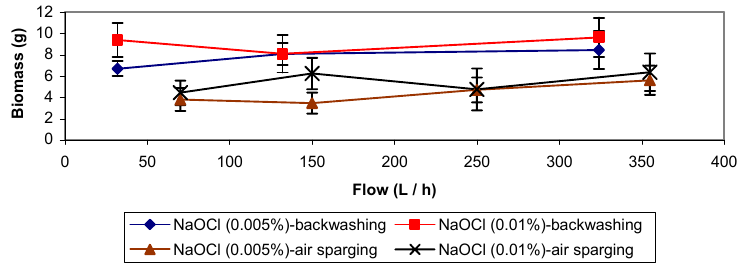
Figure 6. Backwashing and air sparging treatments with NaOCl